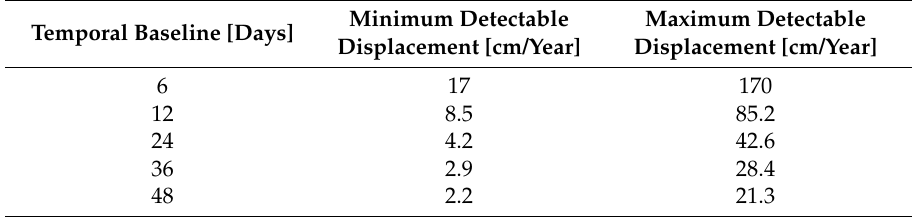
Table 1. Rough estimation of the minimum displacement rate in an interferogram as a function of the temporal baseline for the C-Band of Sentinel